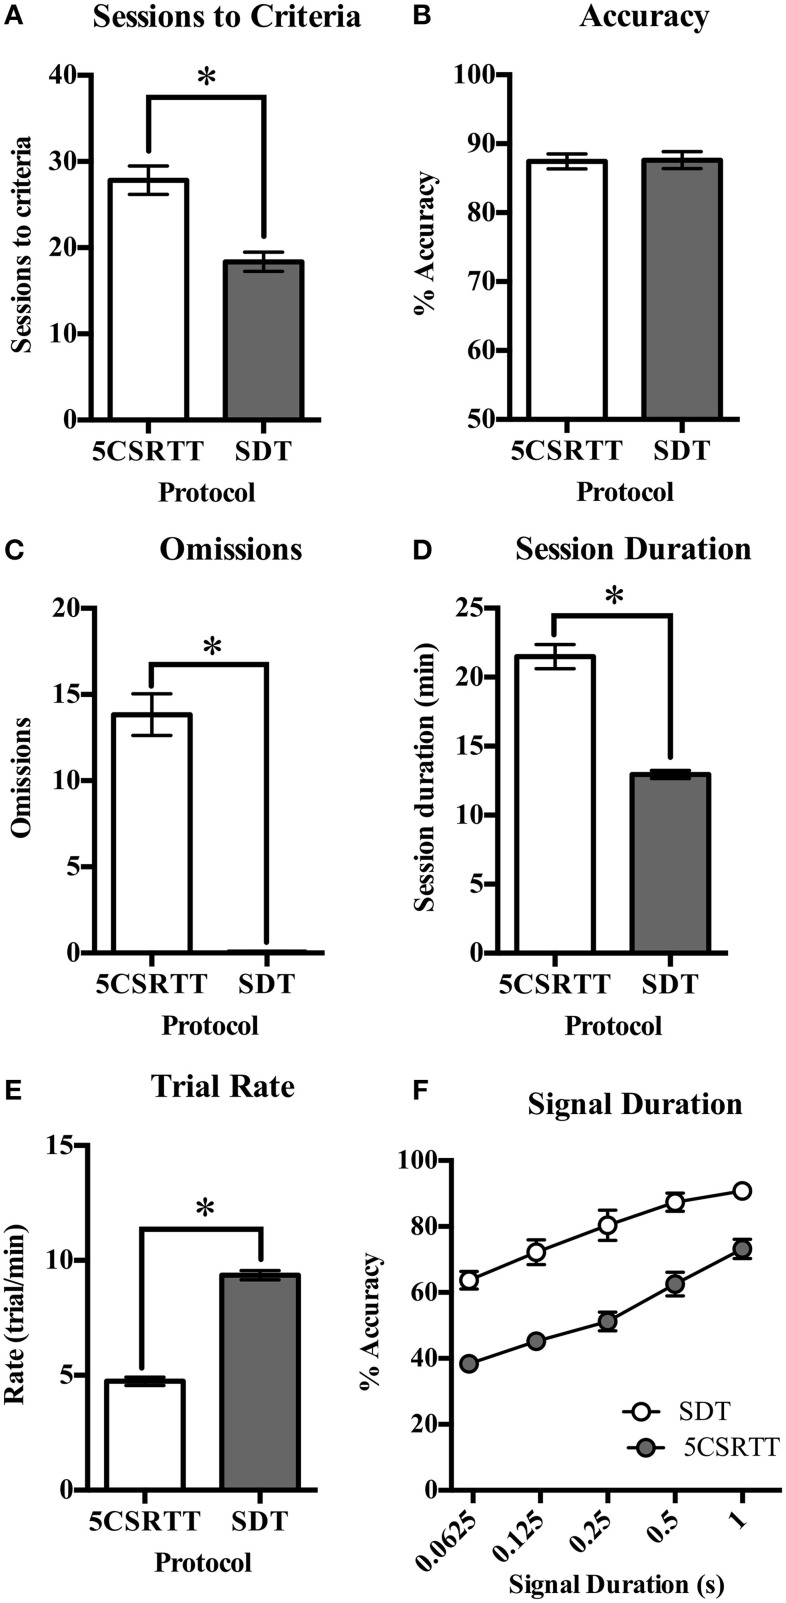
Comparison of performance measures on 5CSRTT and SDT. (A) The number of sessions required to train rats to the final level of 5CSRTT was significantly greater than the number of sessions required to train rats on the SDT. (B) Accuracy was not different between the two protocols. (C) The number of omissions was greatly reduced on the SDT compared to the 5CSRTT. (D) The average session duration was significantly longer for rats to complete 5CSRTT (100 trials) than the time taken to complete the SDT (120 trials). (E) This was also reflected in the trial rate, where a significantly greater number of trials were completed per minute on the SDT compared to the 5CSRTT. (F) The reduced signal duration manipulation led to a decrease in accuracy on both the 5CSRTT and SDT. Compared to baseline testing with only 1 s signal duration trials (Figure 3A), accuracy at 1 s remained high on SDT (from 87.6 to 90.8%) but was reduced on 5CSRTT (from mean of 87.4–73.2%) possibly due to fatigue effects (Figure 4A). n = 18/task, *p < 0.05.